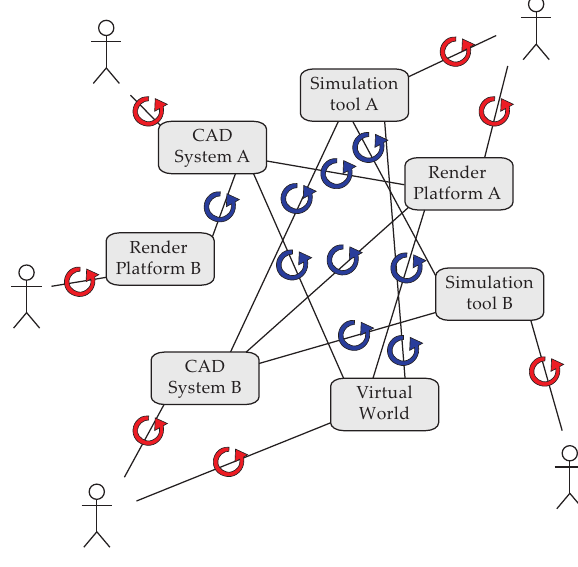
Figure 1. A schema of the typical process of information exchange in an architecture, engineering and construction (AEC) project, with human users in the outer circle, information systems in the inner circle, and connection lines displaying information exchange routes. Interface points (circular arrows) are points where information is interpreted from one information structure into the other, both between human users and information systems (in red) and among information systems (in blue).